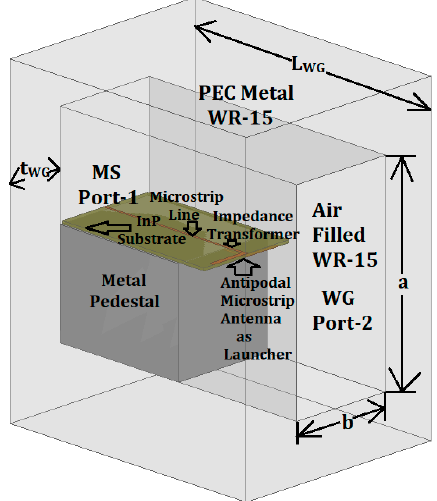
Figure 1. V-band inline transition of the MSL-to-RWG transition.